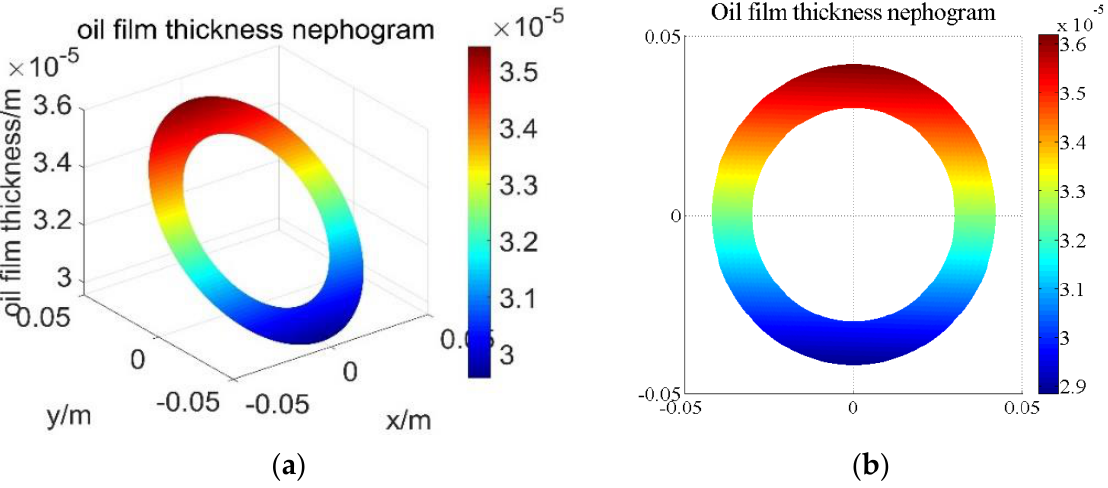
Figure 4. Oil film thickness distribution: ( a ) three-dimensional diagram of oil film distribution; ( b ) top view of wedge oil film thickness.